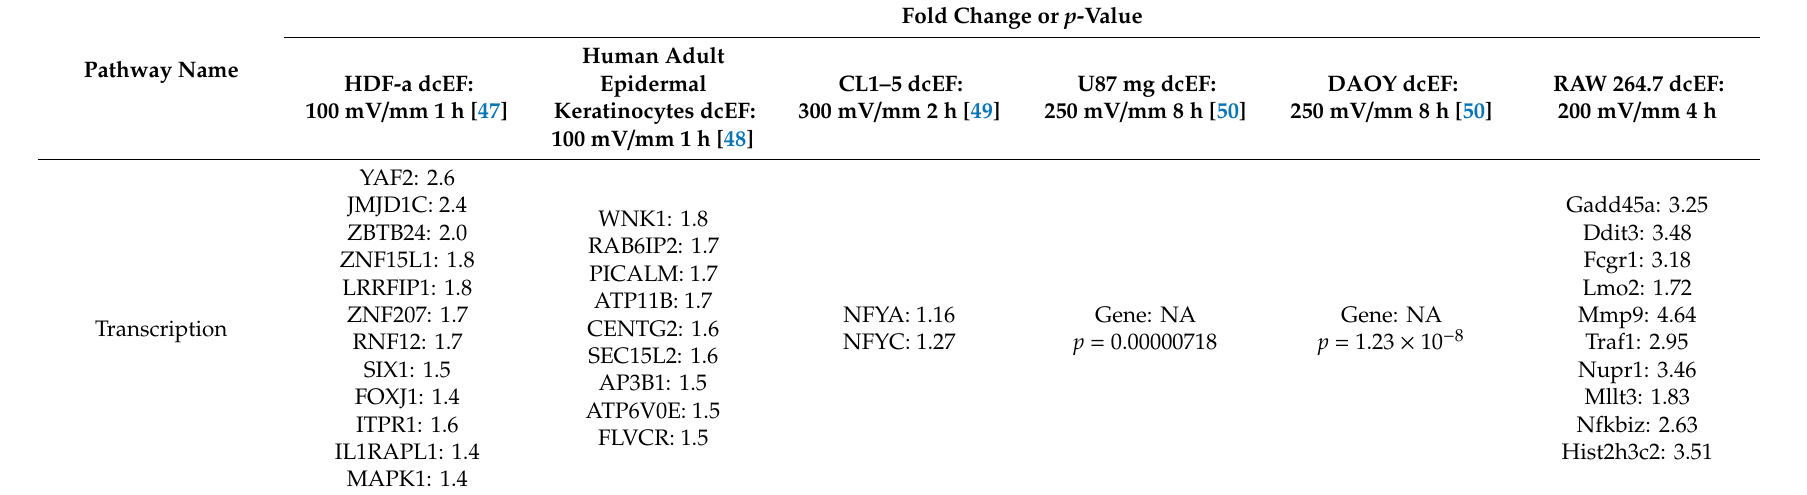
Table 8. Comparison of EF-induced gene expression pathway changes in human and mouse